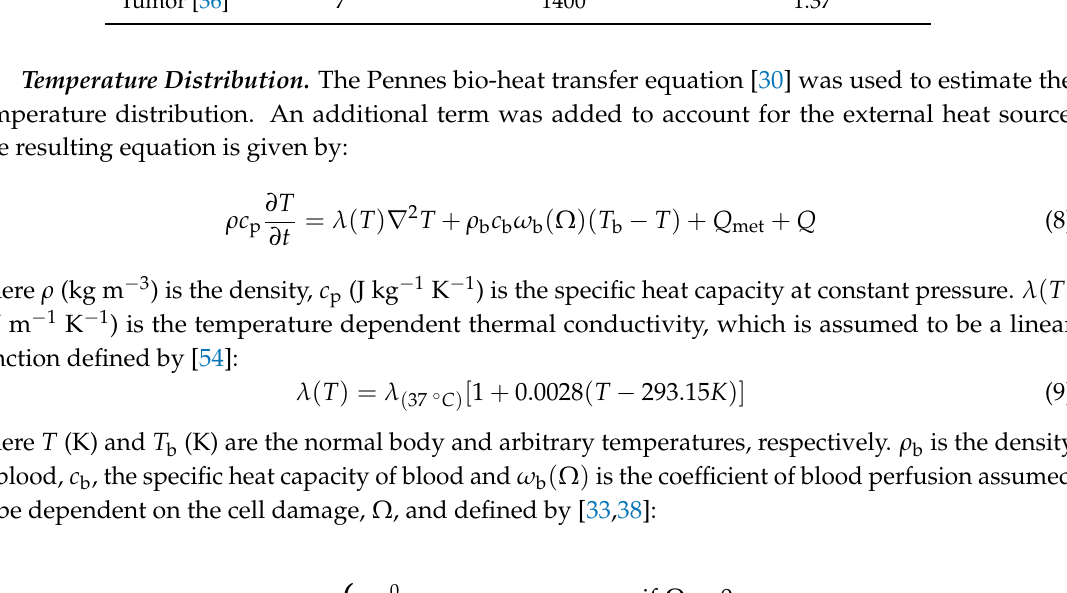
Table 2. Optical properties of the biological domains that were used in the simulations. The values were obtained from Refs. [34–36]. Coefficients, (m − 1 ) Refractive Index, (1) Tissue Absorption, µ a Reduced Scattering, µ (cid:48) s n Fat [35] 3 950 1.455 Gland [35] 6 1100 1.4 Muscle [34] 23 130 1.37 Tumor [36] 7 1400 1.37